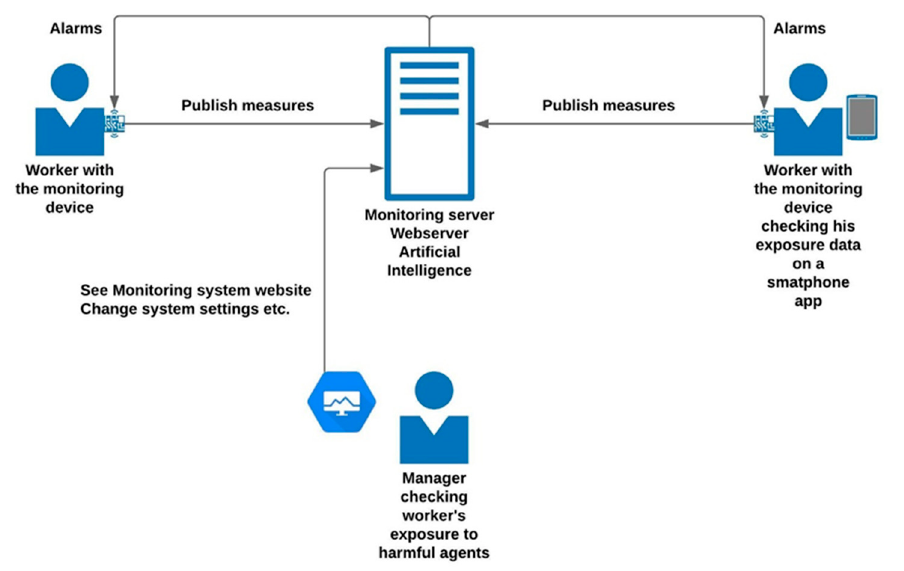
Figure 1. Monitoring system architecture overview.